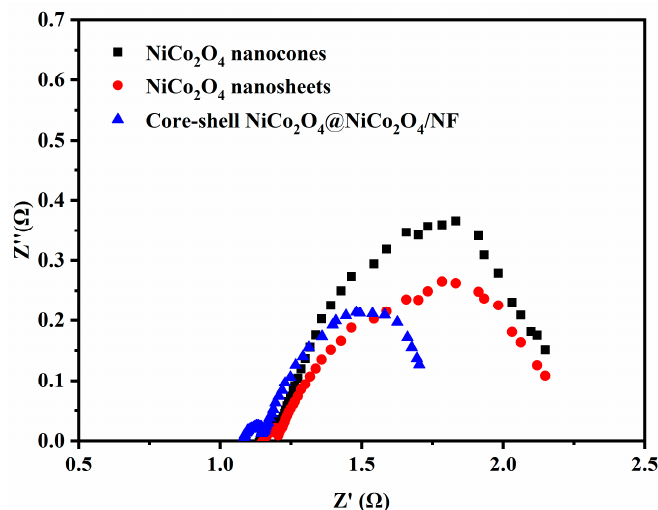
Figure 8. The electrochemical impedance spectra of core-shell NiCo 2 O 4 @NiCo 2 O 4 /NF composites, NiCo 2 O 4 nanosheets, NiCo 2 O 4 nanocones.